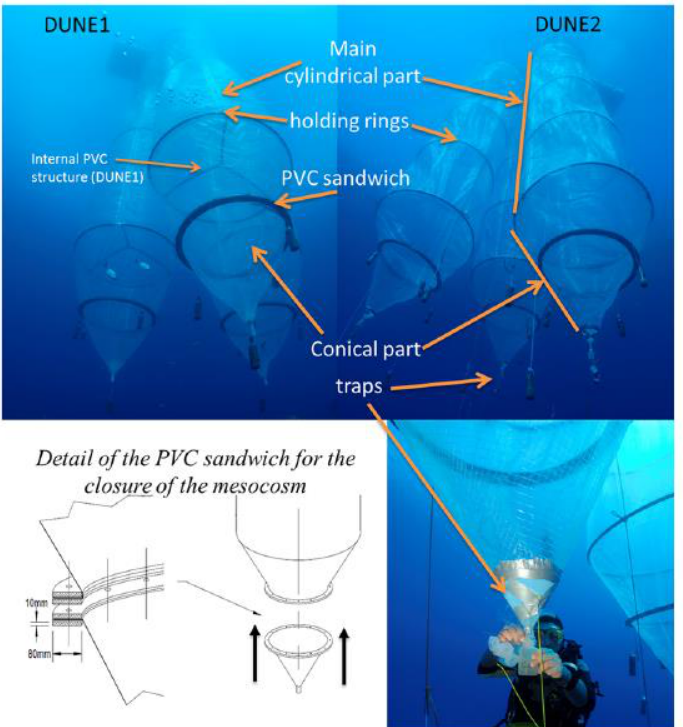
Figure 2. Pictures and schematic representation of the mesocosms underwater developed within the framework of DUNE project. (Reprinted from the work of Guieu et al. [48], under the Creative Commons Attribution 4.0 License).